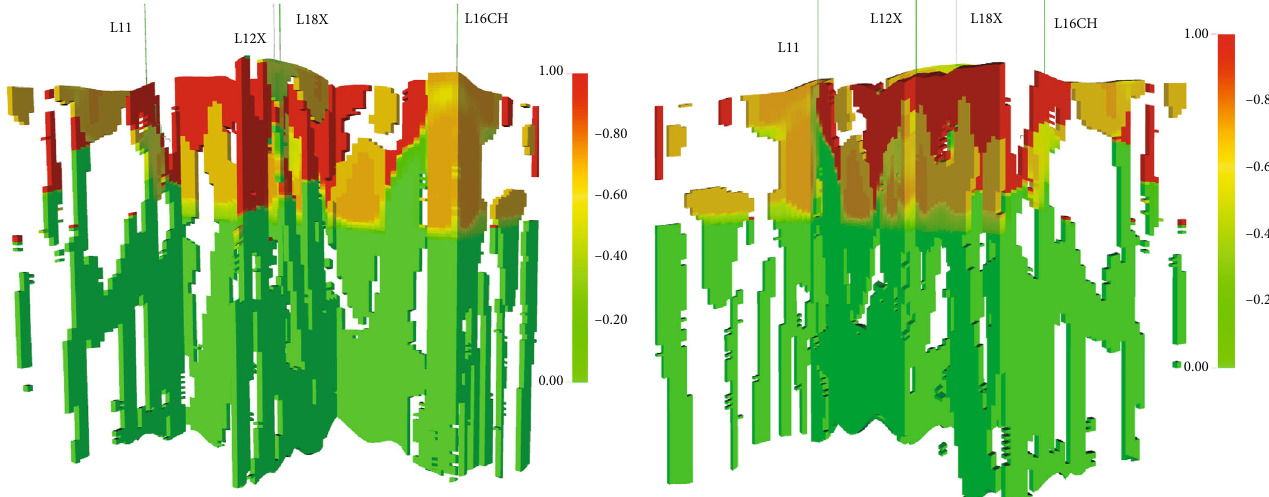
Figure 14: Residual oil distribution between L11, L12X, and L16CH